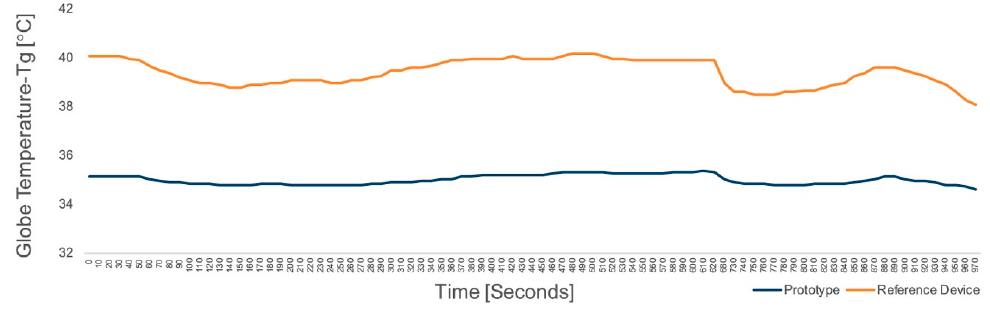
Figure 11. Validation graph for globe temperature.